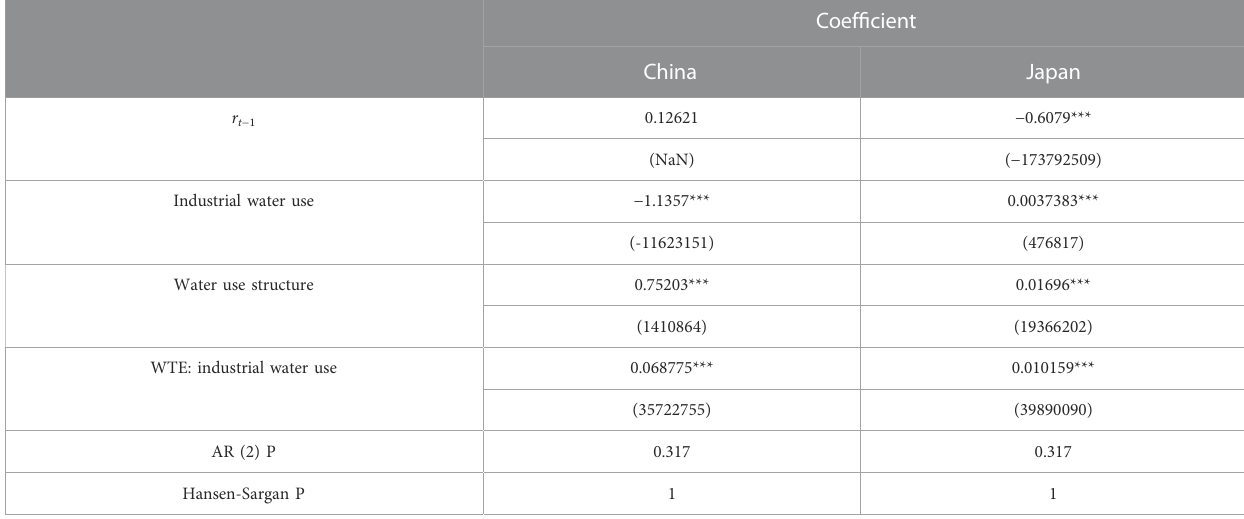
TABLE 7 Role of technology in the mechanism of industrial water use affecting stock market